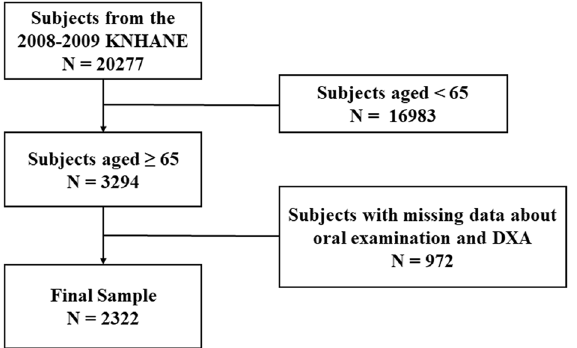
Figure 1. Flow diagram of the study enrollment. KNHANES, Korea National Health and Nutritional Examination Survey; DXA, dual-energy X-ray